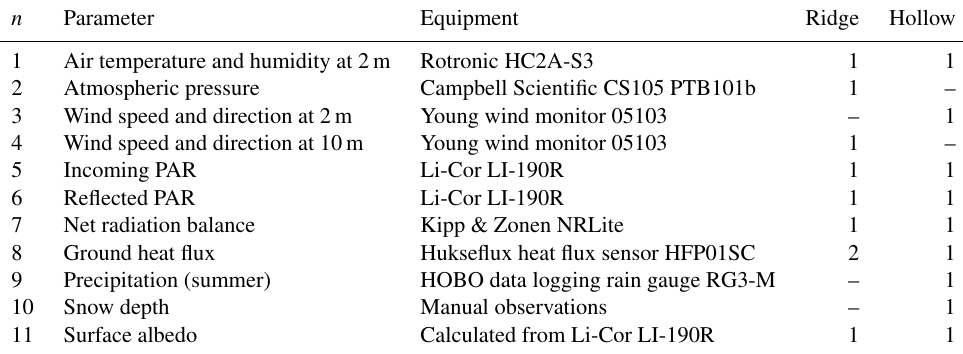
Table 1. List of sensors, parameters, and installation site at Mukhrino field station, 2010–2019. n